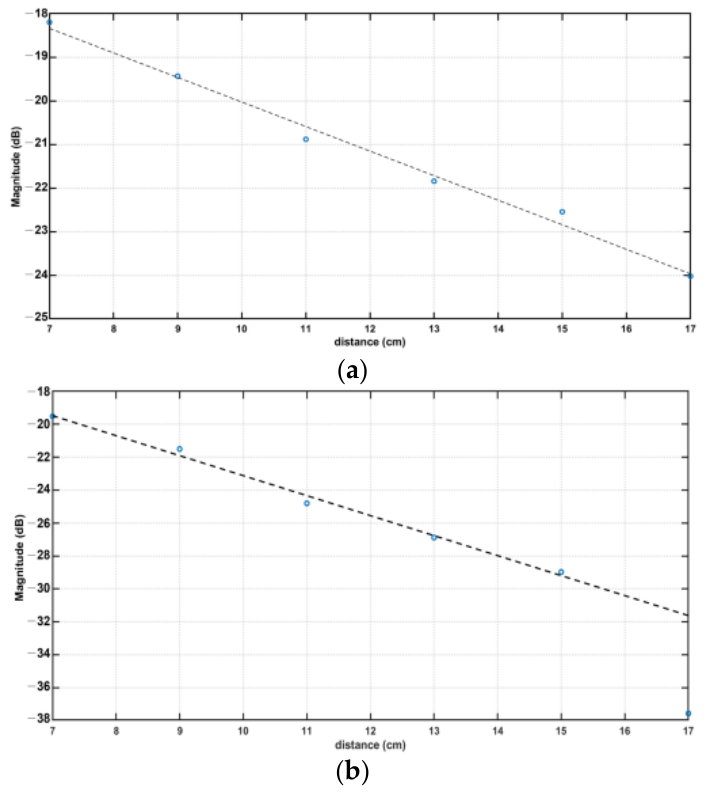
Figure 12. Maximum values of S 12 parameters were measured at distances 7 – 17 cm, ( a ) a 433 MHz antenna ( b ) a 915 MHz antenna. The linear regression of these data presents slopes of − 0.57 (R 2 = 0.99) and − 1.21 (R 2 = 0.99), respectively.